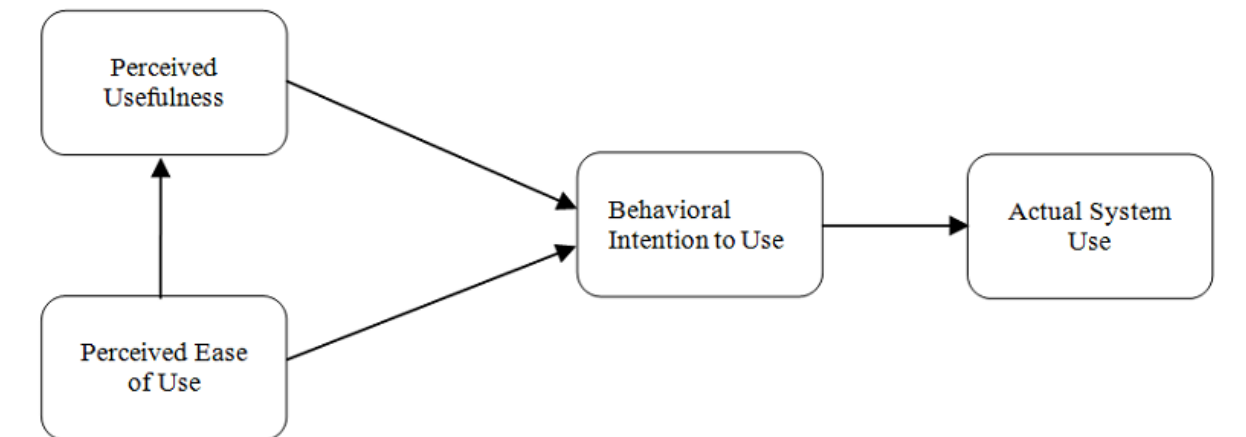
Figure 1. Technology acceptance model